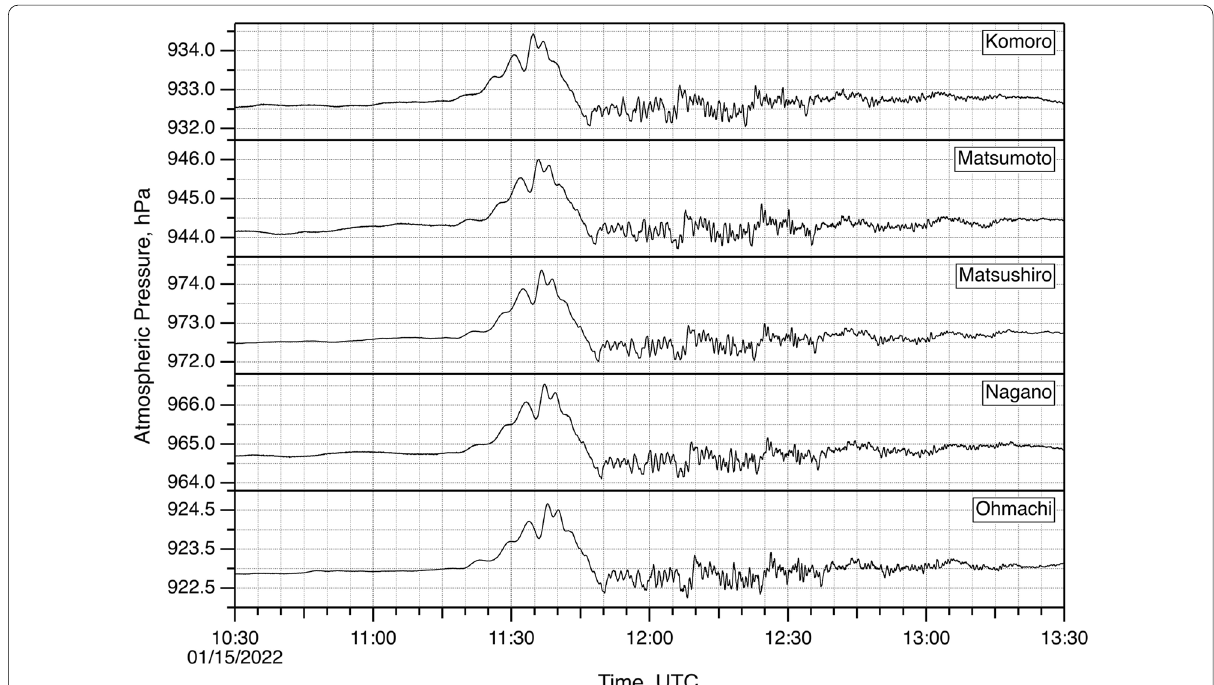
Fig. 2 Barometer records at the stations around Matsushiro, acquired when the atmospheric waves from the Tonga volcano passed the stations. The data at Matsumoto and Nagano shown here have been corrected for the estimated time shift ( acquisition system